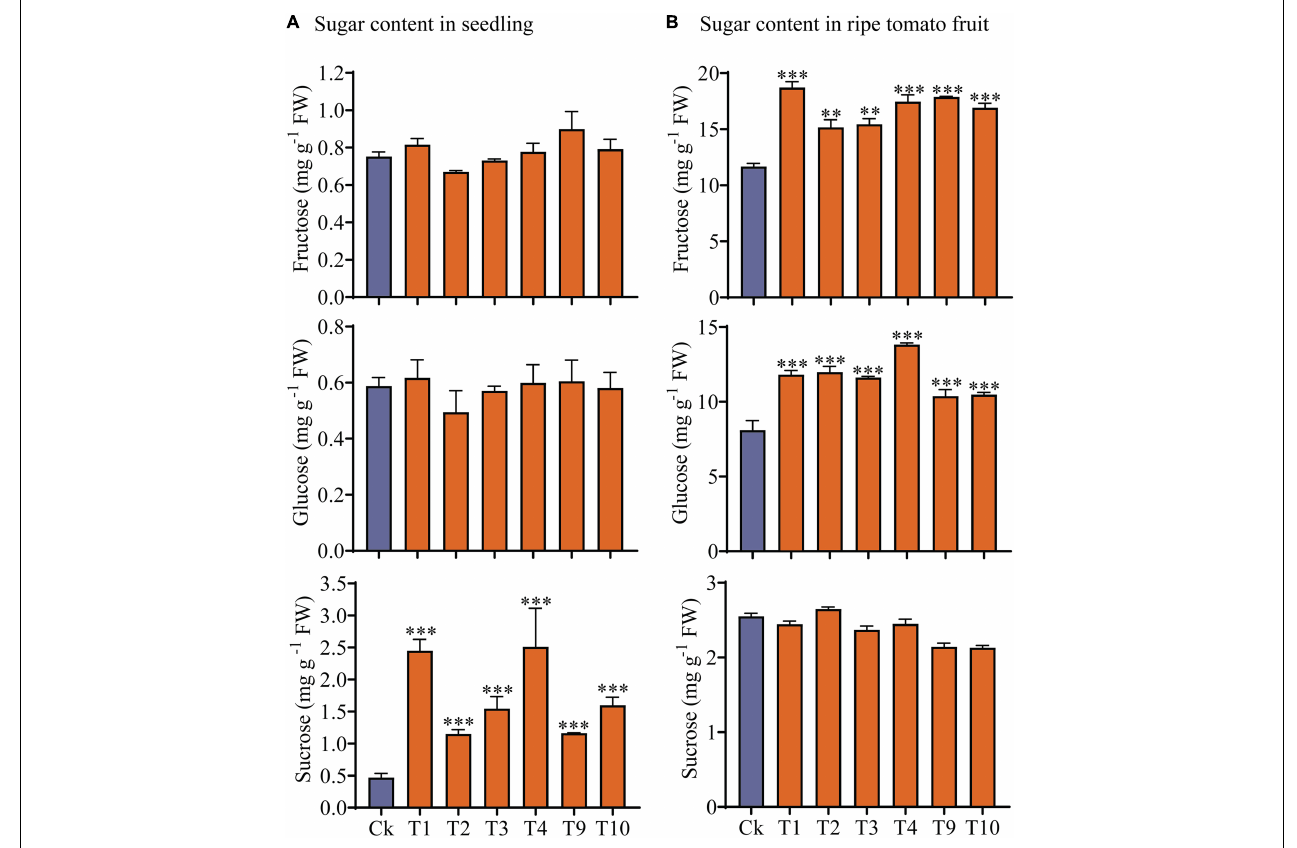
FIGURE 6 | Analysis of sugars content in transgenic and control plants. (A) Sugar content in 7-day-old (4 DAGs) transgenic plants and control plants. (B) Sugar content in mature fruit of transgenic and non-transgenic plants. Values are mean ± standard deviation of three replicates. Statistical analysis was performed with the SPSS software (v19.0); one-way ANOVA followed by Dennett’s multiple comparisons was performed ( ∗∗ p < 0.01; ∗∗∗ p <